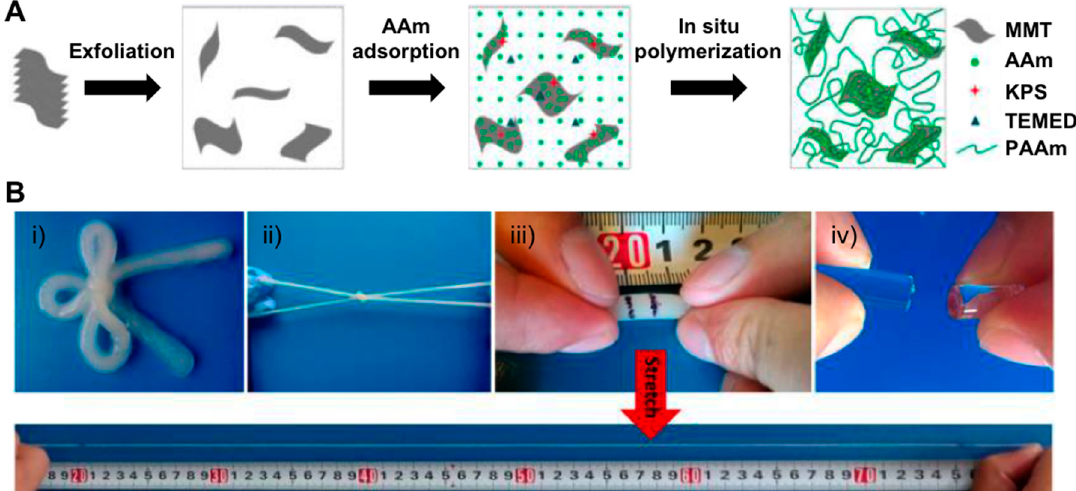
Figure 1. ( A ) Schematic illustration of the synthesis of hydrogels containing montmorillonite (MMT) and poly(acrylamide) (PAAm). ( B ) Photographs of hydrogels: ( i – iii ) Hydrogel (10 wt.% of clay with respect to AAm) bow-tie and that highly stretched to a strain of 11,000%. ( iv ) Covalently cross-linked PAAm hydrogel with 0.1 mol% N , N’ -methylene-bis(acrylamide) (MBAAm) shows a brittle fracture at low strain. Adapted with permission from Reference [39]. Copyright 2015 American Chemical Society.